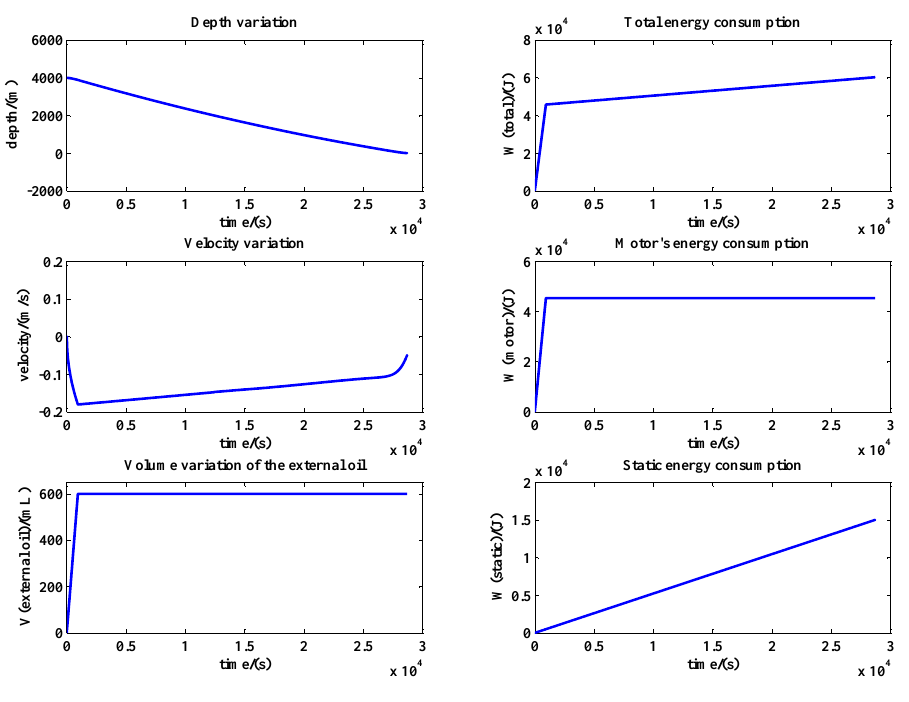
Figure 14. Parameters of the DSPB’s ascent stage of the one-time oil draining